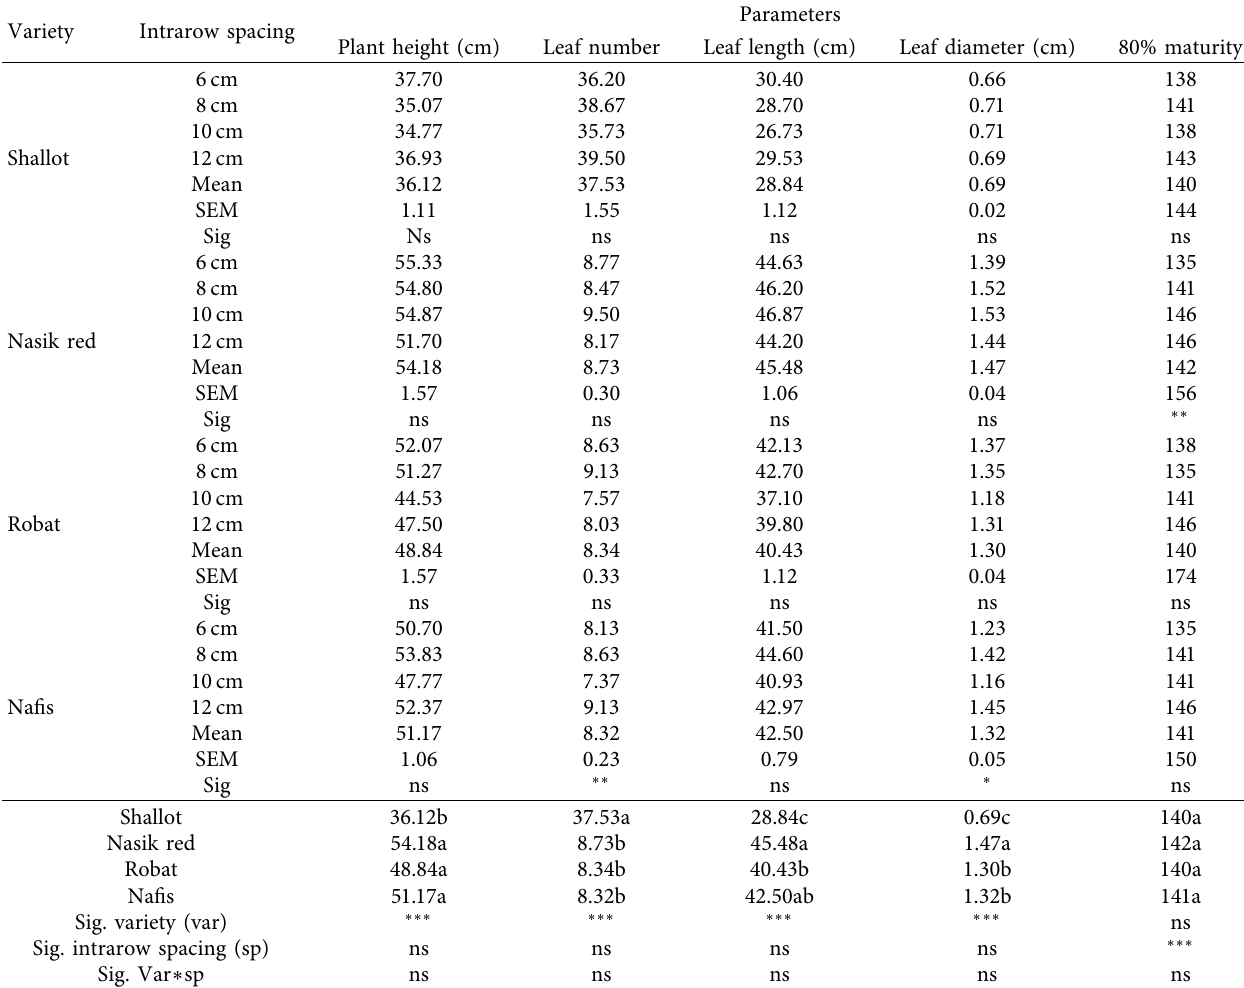
Table 4: Efects of plant varieties and intrarow spacing on plant morphological characteristics.